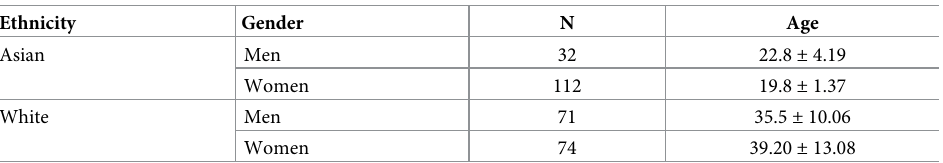
Table 1. Participants’ demographic